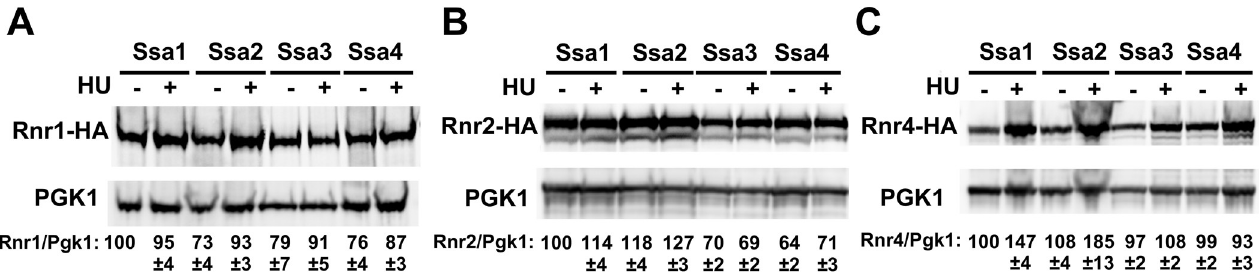
Fig 2. Steady-state levels of RNR small subunits are dependent on Ssa paralogs. ssa1-4 Δ cells expressing either Ssa1, 2, 3 or 4 and endogenously tagged Rnr1-HA, Rnr2-HA or Rnr4-HA were grown to exponential phase and were either left untreated or were treated with 200mM HU for 3 hours. Cell extracts were obtained, resolved on SDS-PAGE gels and analyzed by immunoblotting with anti-HA and PGK1 antibodies. PGK1 was used as a loading control. The ratio of RNR subunit/PGK was quantified and determined from three replicate experiments.